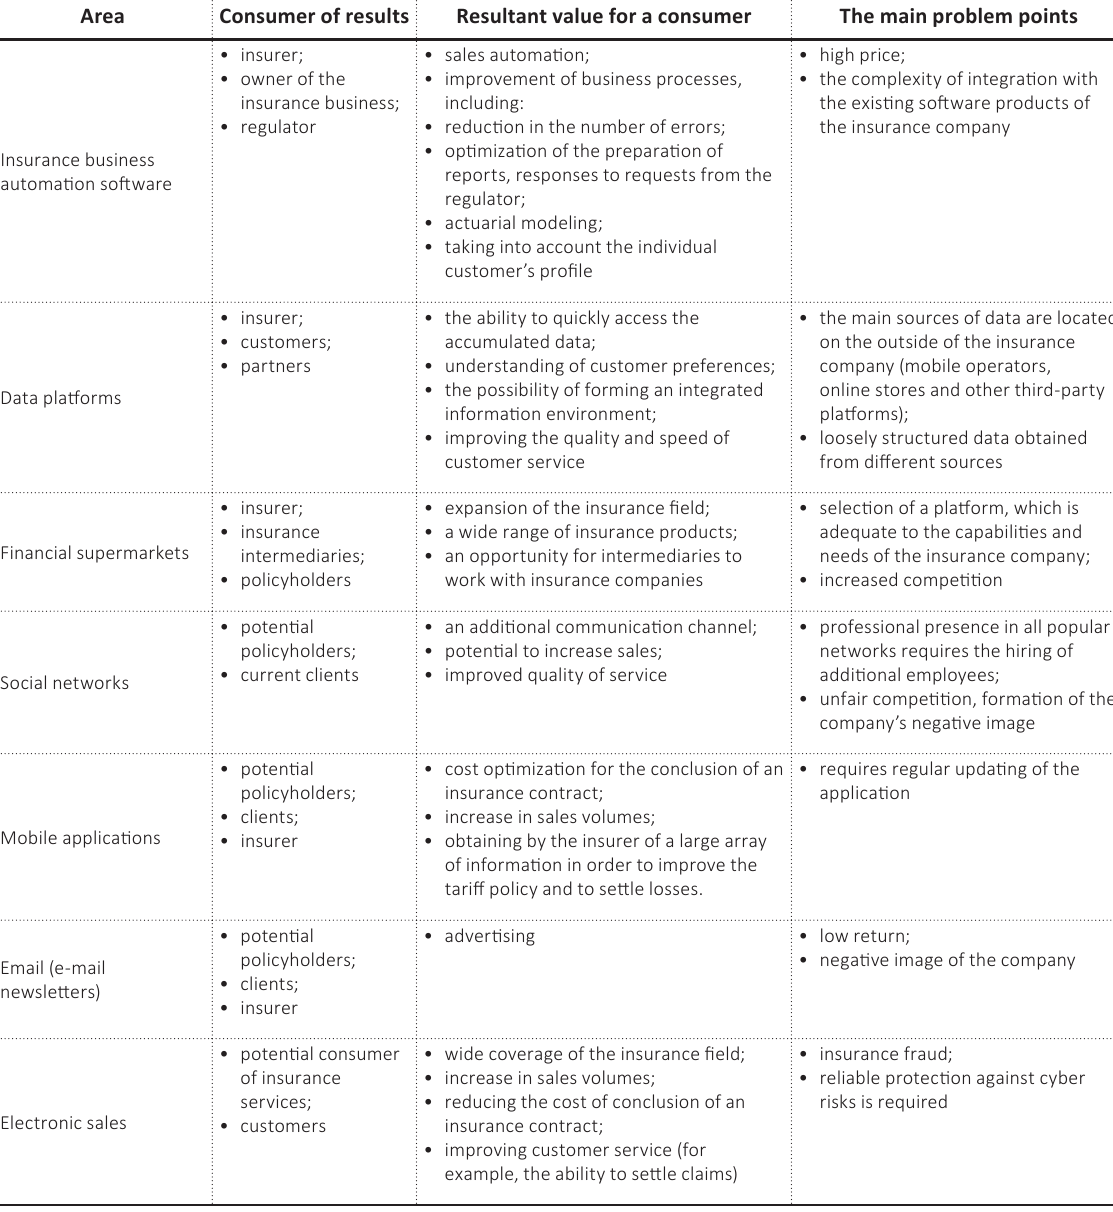
Source: Compiled by the